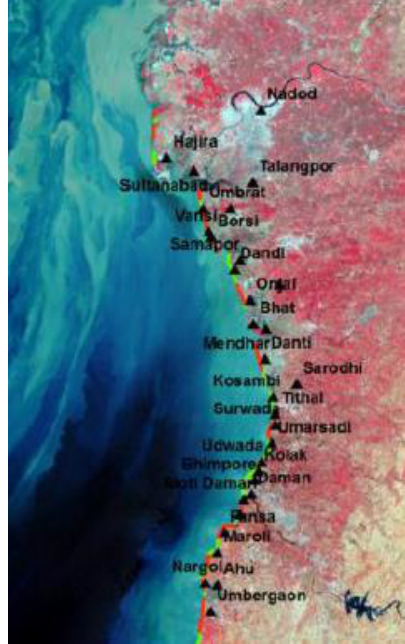
Fig. 1: Shoreline changes between 1990- 2014, analysis provided in DSAS, source: Misra and Balaji (2015) Water erosion of the river Trkmanka shoreline (a small stream in South Moravia, the Czech Republic) was studied by Pechanec et al. (2015). They focused on erosion susceptibility and shoreline changes because they assumed that water erosion destructively influences the soil surface. This method provides maximum volume of soil erosion caused by